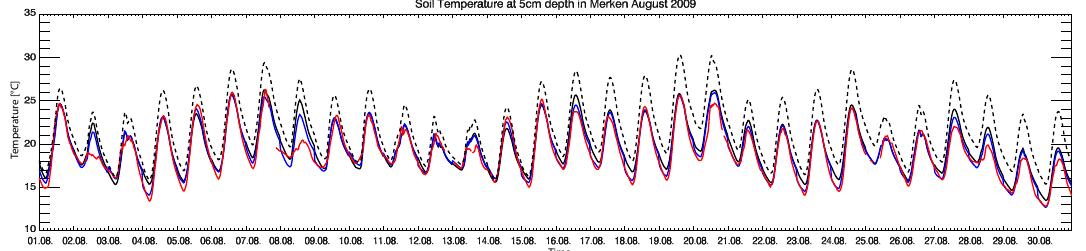
Figure 5. Soil temperature in Merken in August 2009 at 5cm depth. The black dashed curve shows the control run, the black solid curve shows the CLM forecast based on the analysis of the previous day, while the blue curve depicts the analysis. Measurement values are shown as a red line.